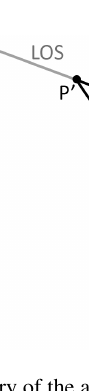
Figure A1. Geometry of the atmospheric